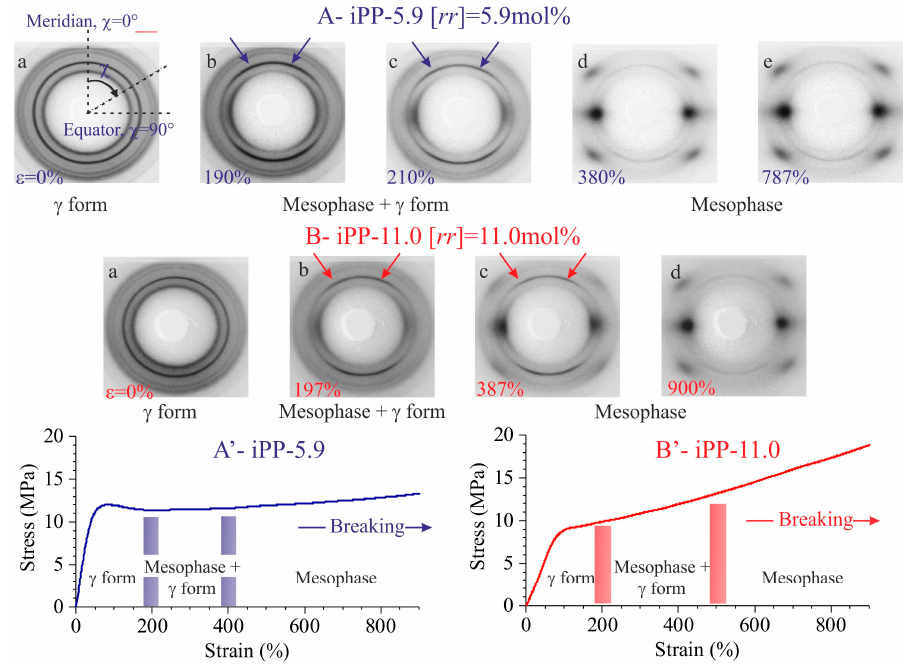
Figure 1. Stress strain curves ( A’ , B’ ) and bidimensional WAXS patterns of the sample iPP-5.9 ( A ) and iPP-11.0 ( B ) at the indicated deformations. The critical values of deformation marking the beginning ( ε start ), and the complete ( ε end ) transformation of the initial γ form into mesophase are indicated by the vertical bold lines in ( A’ , B’ ). The stretching direction is vertical. Arrows in b and c indicate the polarization of the (008) γ reflection of γ form, off the equator (horizontal direction) and off the meridian (vertical direction), defined in the image a of part A of the figure, occurring at low deformations, due to orientation of the crystals of the γ form with chain axes nearly perpendicular to the stretching direction, as indicated in Figure 4. The azimuthal angle χ is defined in the image a of part A.